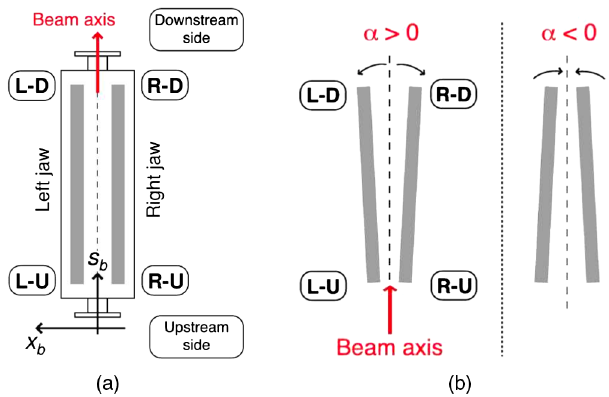
FIG. 1. (a) The collimator coordinate system and (b) the jaw tilt angular convention as viewed from above, from